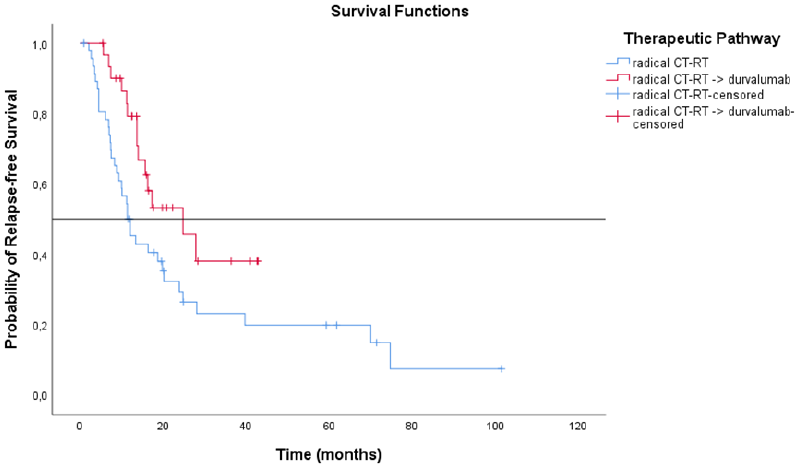
Figure 16. Kaplan–Meier curves of estimated relapse-free survival in the entire population who underwent definitive chemo-radiation therapy according to treatment pathway. CT-RT, chemo-radiation therapy.